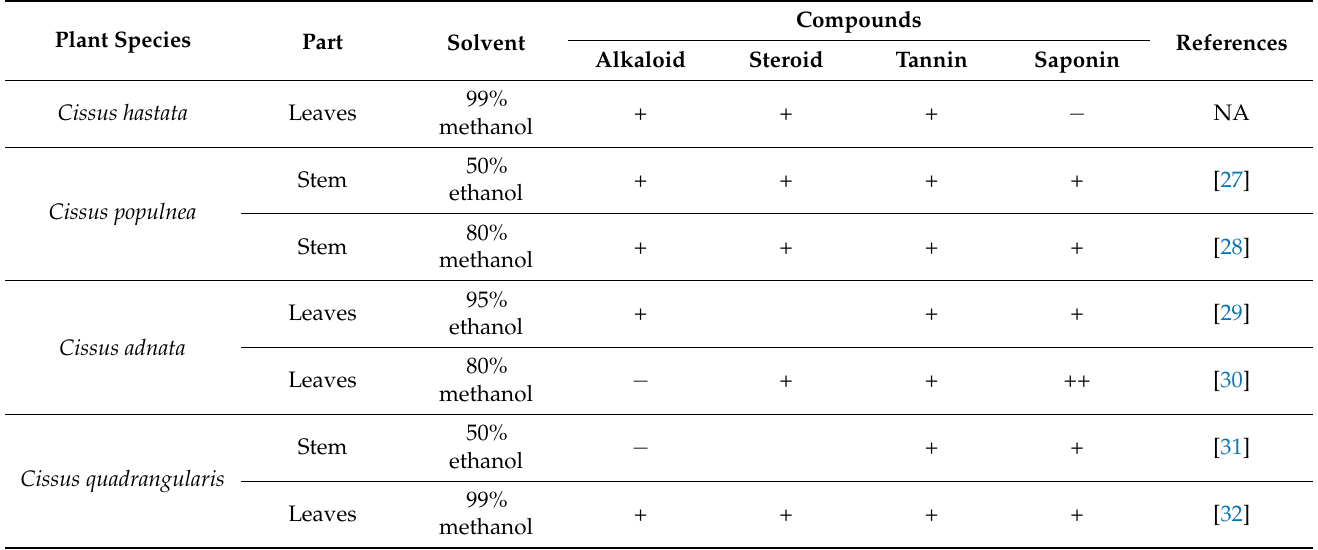
Table 3. List of the different solvent extraction methods on different Cissus sp. for the comparison of effectiveness in the determination of bioactive